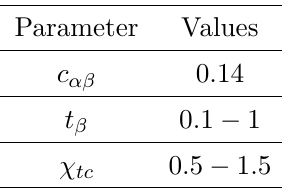
Table 2. Values for the free model parameters used in this